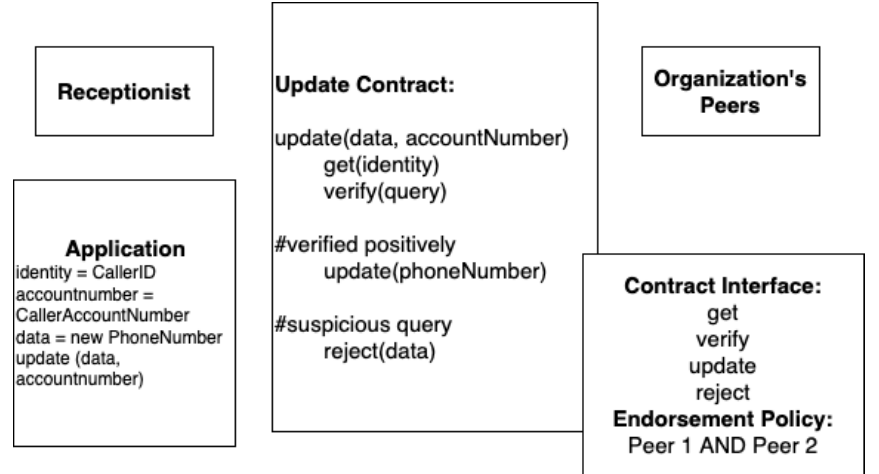
Figure 4. Smart contract structures, methods, and endorsement